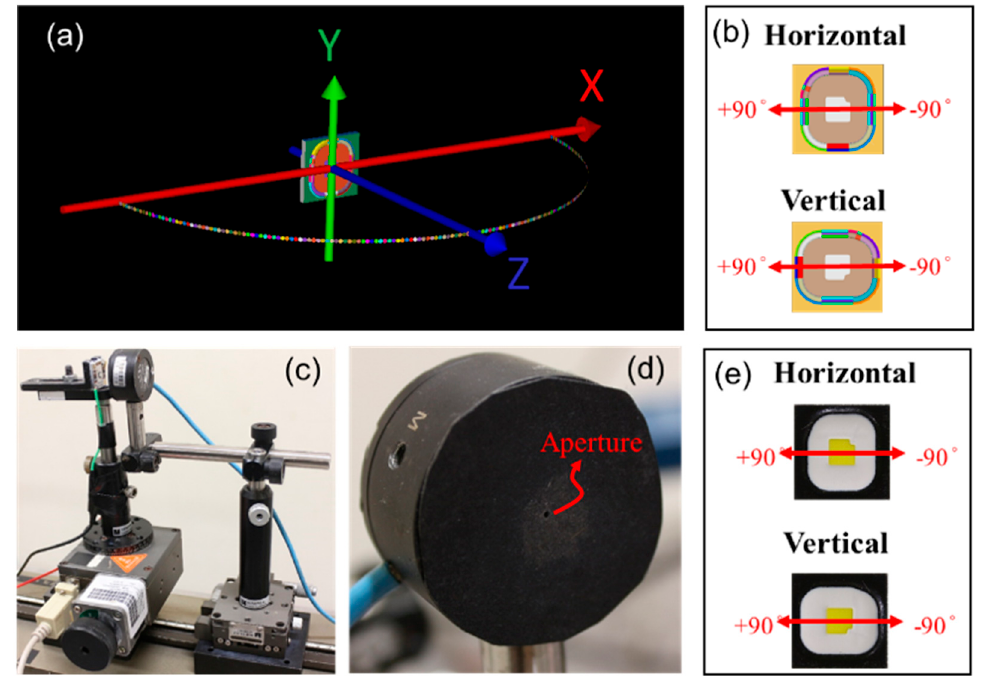
Figure 2. ( a ) Algorithm used in the simulation along the ( b ) horizontal and vertical directions. ( c ) Optical setup in the experimental measurement, with a controllable iris shown in ( d ), along the ( e ) horizontal and the vertical directions.